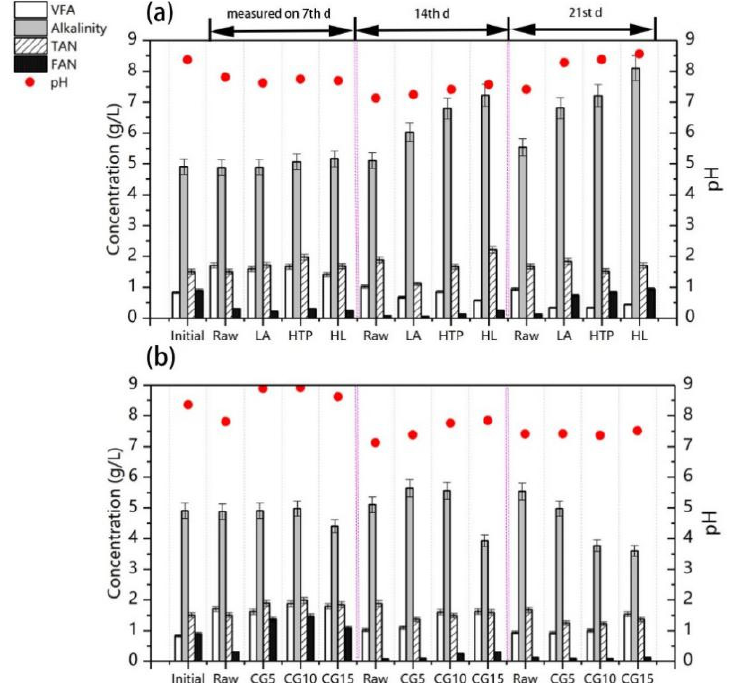
Figure 2. VFA, alkalinity, TAN, and FAN contents, and pH of digesters (measured every 7 d) during the whole AD process: ( a ) raw and pretreated FW mono-digestion; ( b ) FW co-digestion with CG (5%, 10%, and 15% of VS).